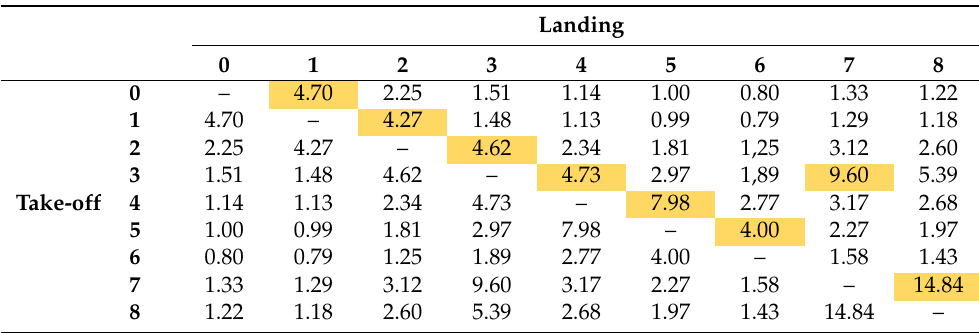
Figure 7. Dependence of monitoring frequency (number of flights per day) on the number of drones. Table 7. Summary table of monitoring frequencies for the different UAV responsibility zone allocation options. The values presented indicate the expected monitoring frequency in a day per drone. Highlighted cells indicate the monitoring frequency between neighbouring take-off and landing points, i.e., the option of using 8 drones in total. The table allows for determining the highest frequency of monitoring of the whole